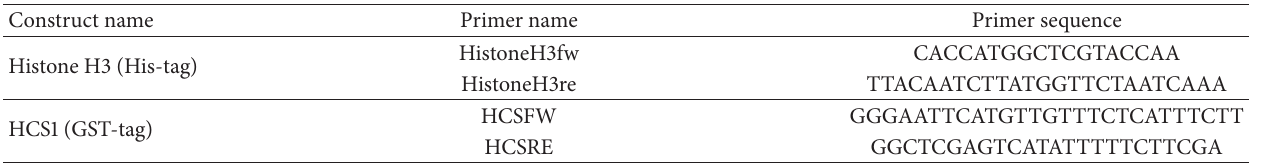
Table 1: Primers used for